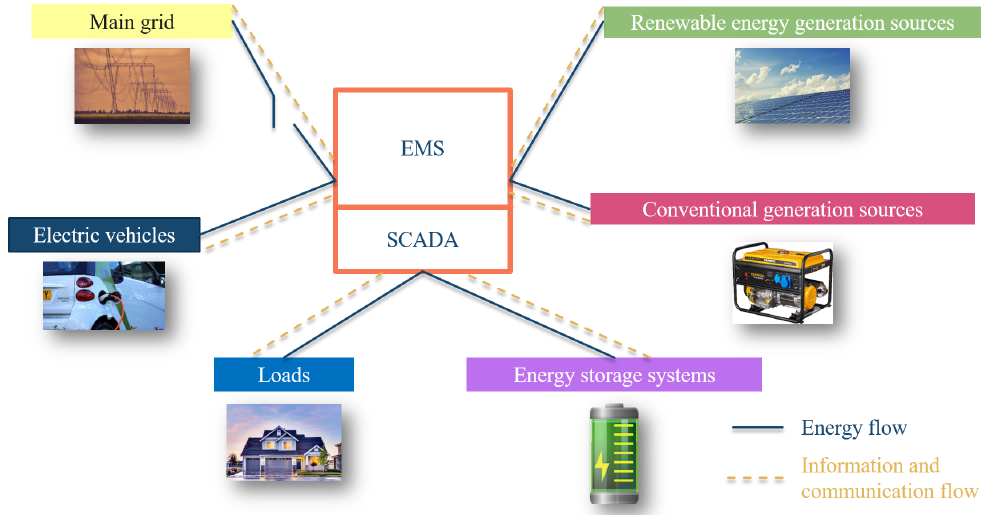
Figure 4. MG components: loads, renewable energy generation sources, conventional generation sources, energy storage systemms, and eletric vehicles. The EMS/SCADA coordinates energy demand and supply between the dispatchable generators and the different loads